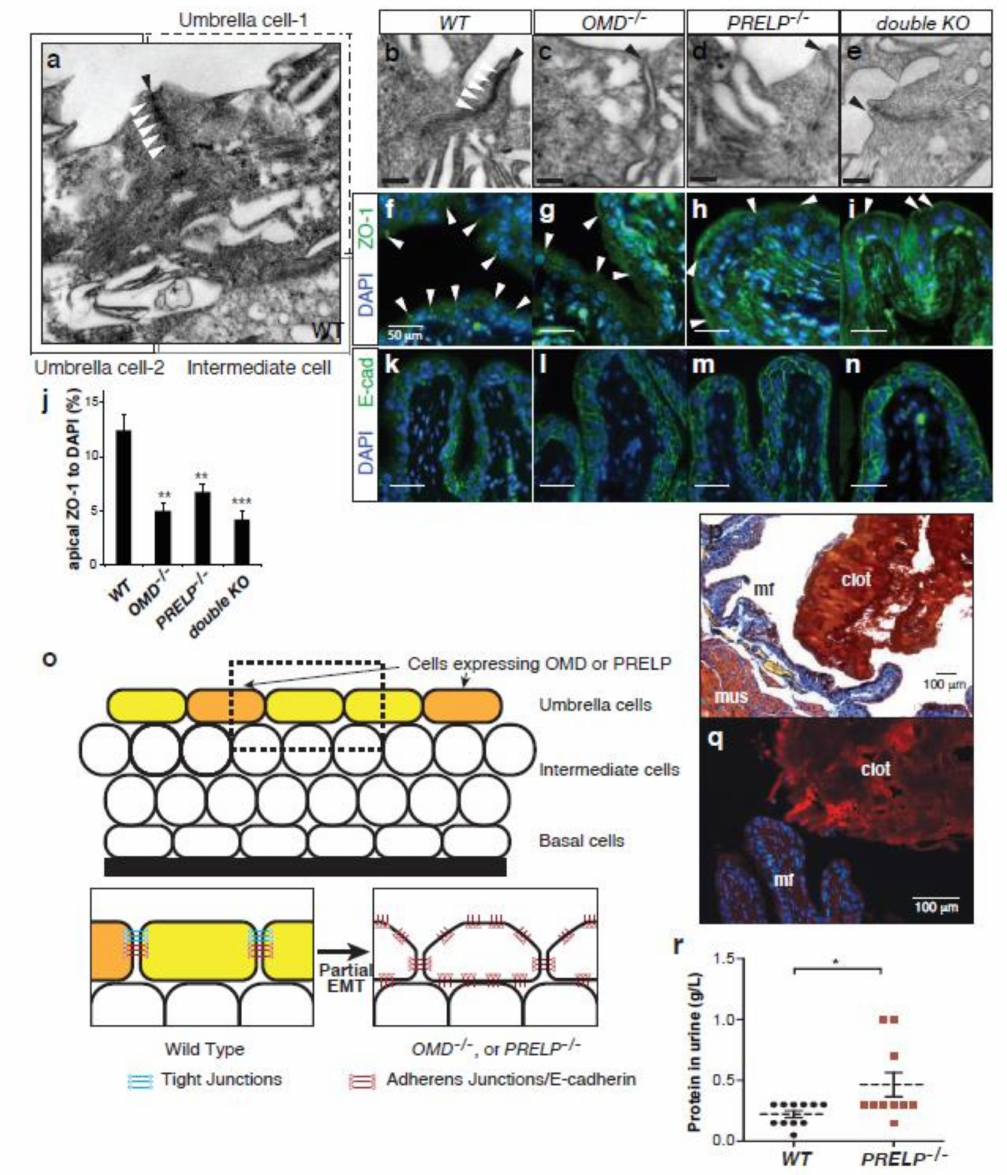
Figure 7. OMD or PRELP knockout resulted in a loss of tight junctions between bladder umbrella cells. ( a – e ) EM analysis of WT ( a,b ), OMD − / − ( c ), PRELP − / − ( d ), and their double ( e ) knockout bladders at 3 months old. A wide view of WT bladder epithelia, which includes two umbrella cells and an intermediate cell. The apical side of the cell–cell surface of umbrella cells (black arrowhead) are strongly sealed by dense tight junctions (white arrowheads) ( a ). Apical side of umbrella cell–cell interfaces. Black arrowheads; cell–cell interfaces. White arrowheads; tight junctions ( b – e ). Scale bar represents 200 nm. ( f – j ) Analysis of ZO-1 staining of a 3-month-old bladder. ZO-1 staining between umbrella cells is indicated by white arrowheads ( f ). Quantification of ZO-1 staining ( j ). ( k – n ) E-cadherin staining of a 3-month-old bladder. ( o ) Model of cell–cell adhesion in bladder epithelial cells. ( p ) Phosphotungstic acid hematoxylin (PATH) staining of 3-month-old PRELP − / − bladder. PATH staining stains fibrin and erythrocytes. ( q ) Fibrin antibody staining of 3-month-old PRELP − / − bladder. ( r ) Analysis of urinary fibrin. Urine samples were collected from WT and PRELP − / − mice at the morning and were tested using Multistix (SIEMENS). *, **, *** indicate p < 0.05, p < 0.01, p < 0.001,